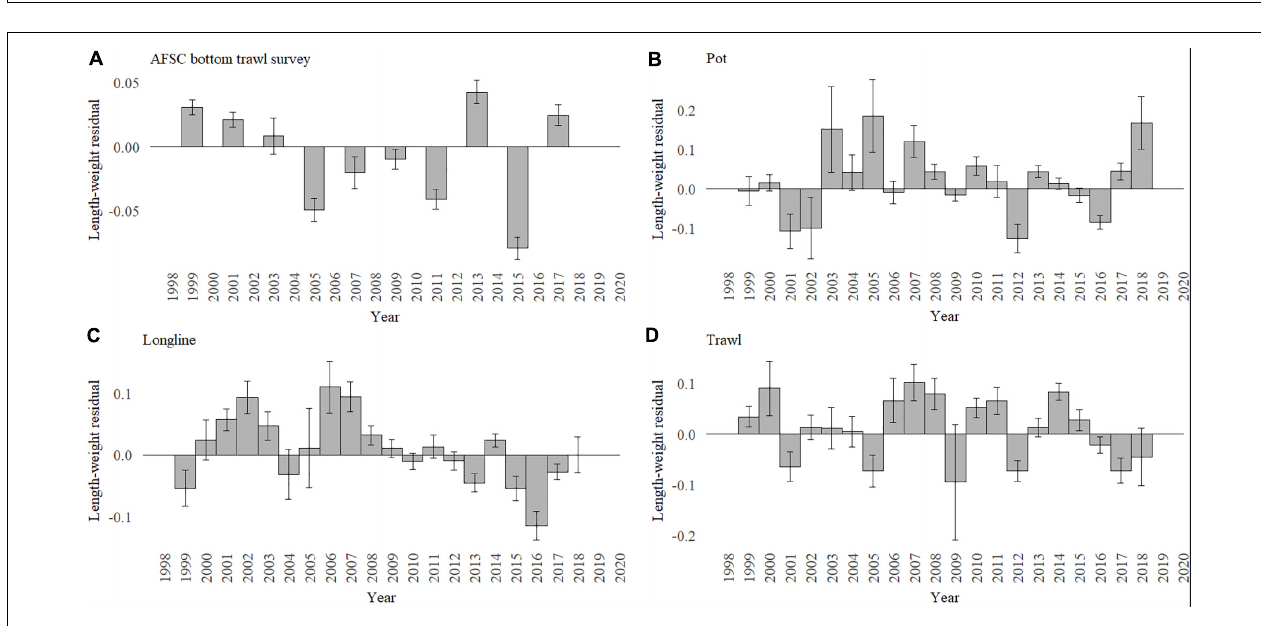
FIGURE 4 | (A) Average prey energy density (ED) for all Alaskan samples (solid line) and for the Gulf of Alaska (red dashed line), (B) daily estimates of growth, and (C) metabolic demand. Average prey ED are based on mean energy density of prey items and diet composition from GOA Pacific cod stomach samples, growth and metabolic demand are based on the adult Pacific cod bioenergetics model (Holsman et al., 2016), a fixed relative foraging rate (RFR) = 0.65 (across years), annual indices of GOA prey energy density, and an intermediate Pacific cod energy density of 3.7 kJ/g reported in Ianelli et al. (2018).